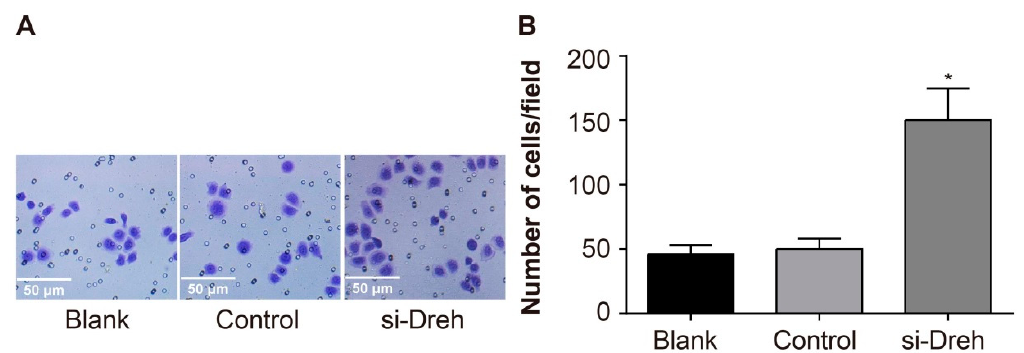
Figure 5. The WB-F344 cells migration is enhanced after silencing of LncRNA-Dreh. * p < 0.05, vs. the blank and control groups. ( A ) the Transwell assay of WB-F344 cells proliferation; Scale bars represent 50 µ m. ( B ) the number of migrated cells of the blank, control and si-Dreh groups. Cells without any transfection were used as the blank group, cells with blank plasmid transfection were used as the control group. The results are given as means ± SD ( n = 3 samples). Enumeration data were performed according to ANOVA with chi-square test ( p < 0.05).